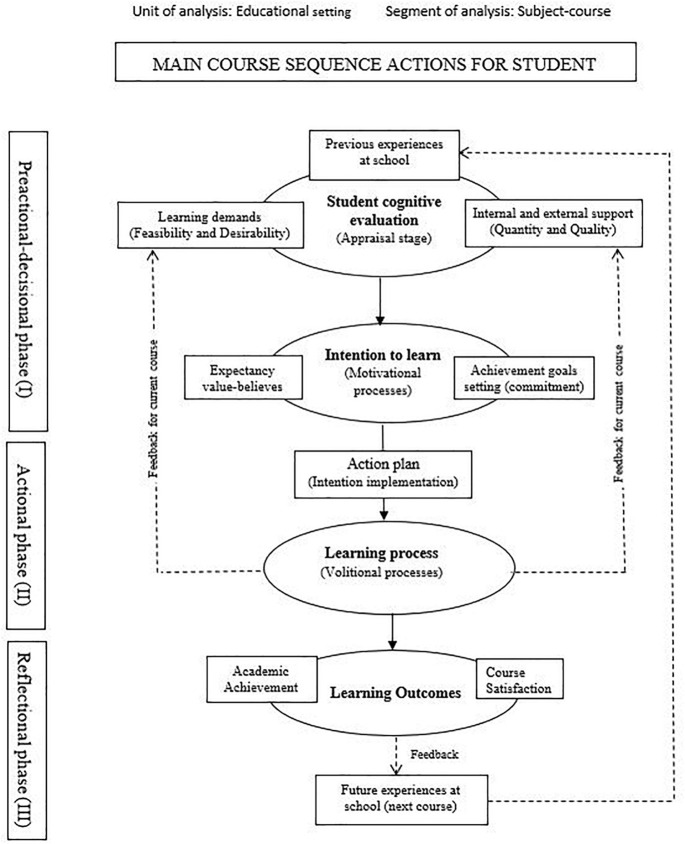
MOCSE diagram: Main course sequence actions for students. 1Connected with students’ interests, needs, and academic level (meaningful demands, Doménech-Betoret, 2018).